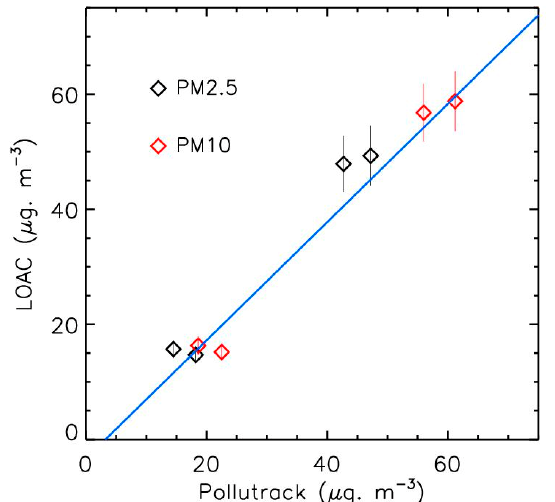
Figure 2. Correlation plot between Pollutrack and LOAC during 4 sessions measurements of 40 min in different streets of Paris.